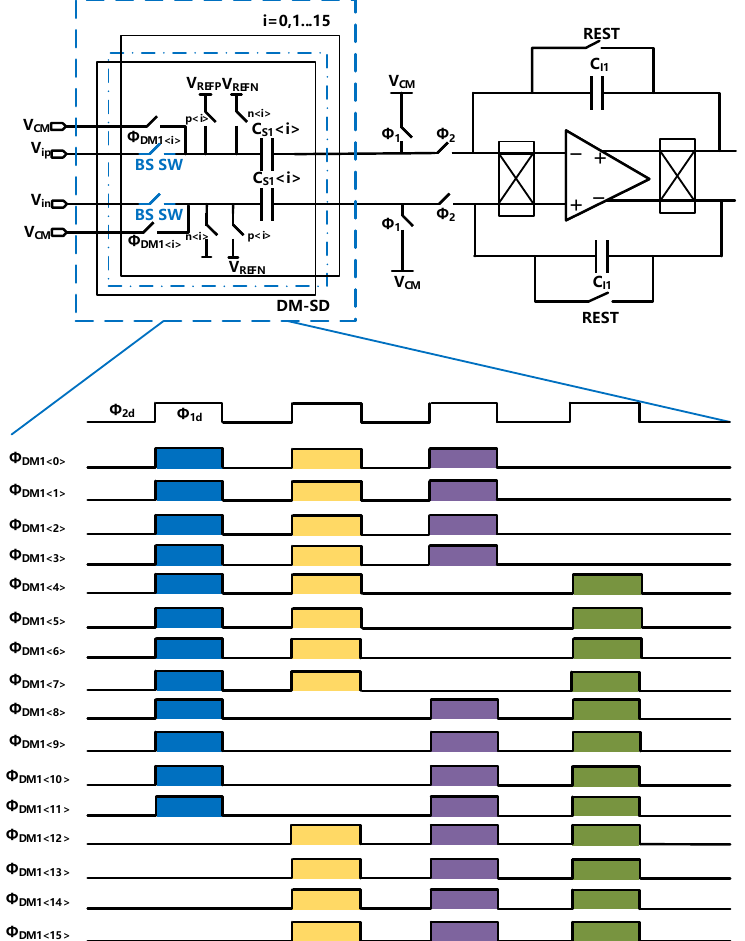
Figure 5. Schematic and timing diagram of the proposed